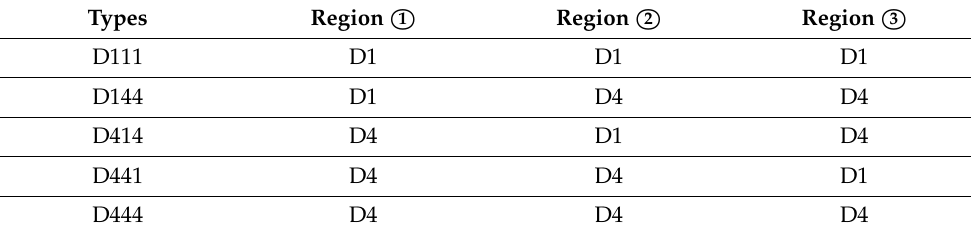
Figure 3. ( a ) 200 N preload of force to tighten the abutment screw to the fi xture, ( b ) mastication load applied in axial and oblique (45°) directions. The bone was divided into three regions of ①–③ according to height. Table 2. Classification of bone model: three bone regions with two bone densities.